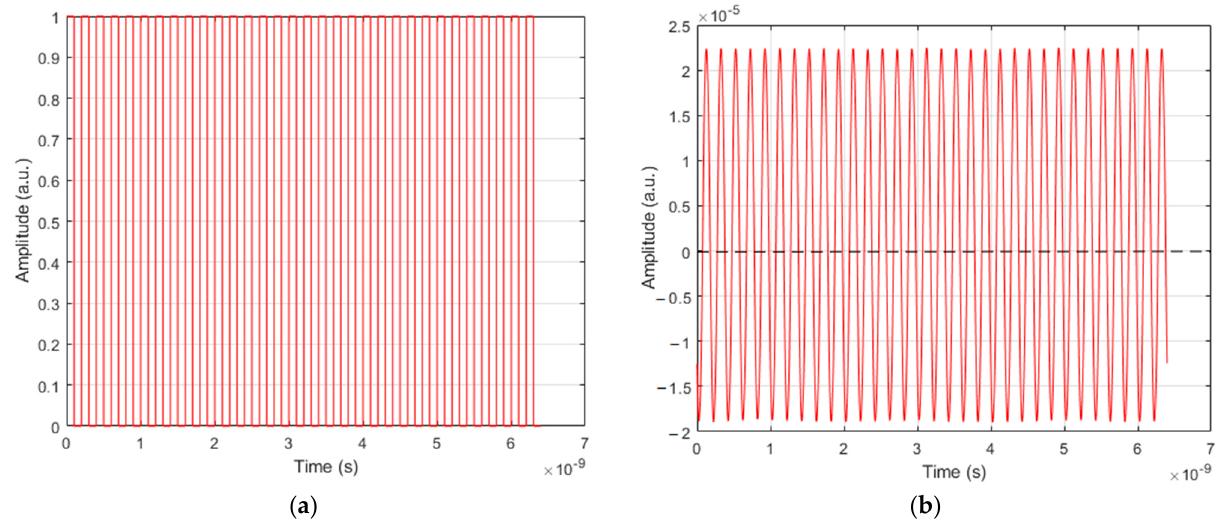
Figure 7. Input and output signals from the proposed bi ‐ OCDMA system: ( a ) binary sequence generated from PRBS; ( b )